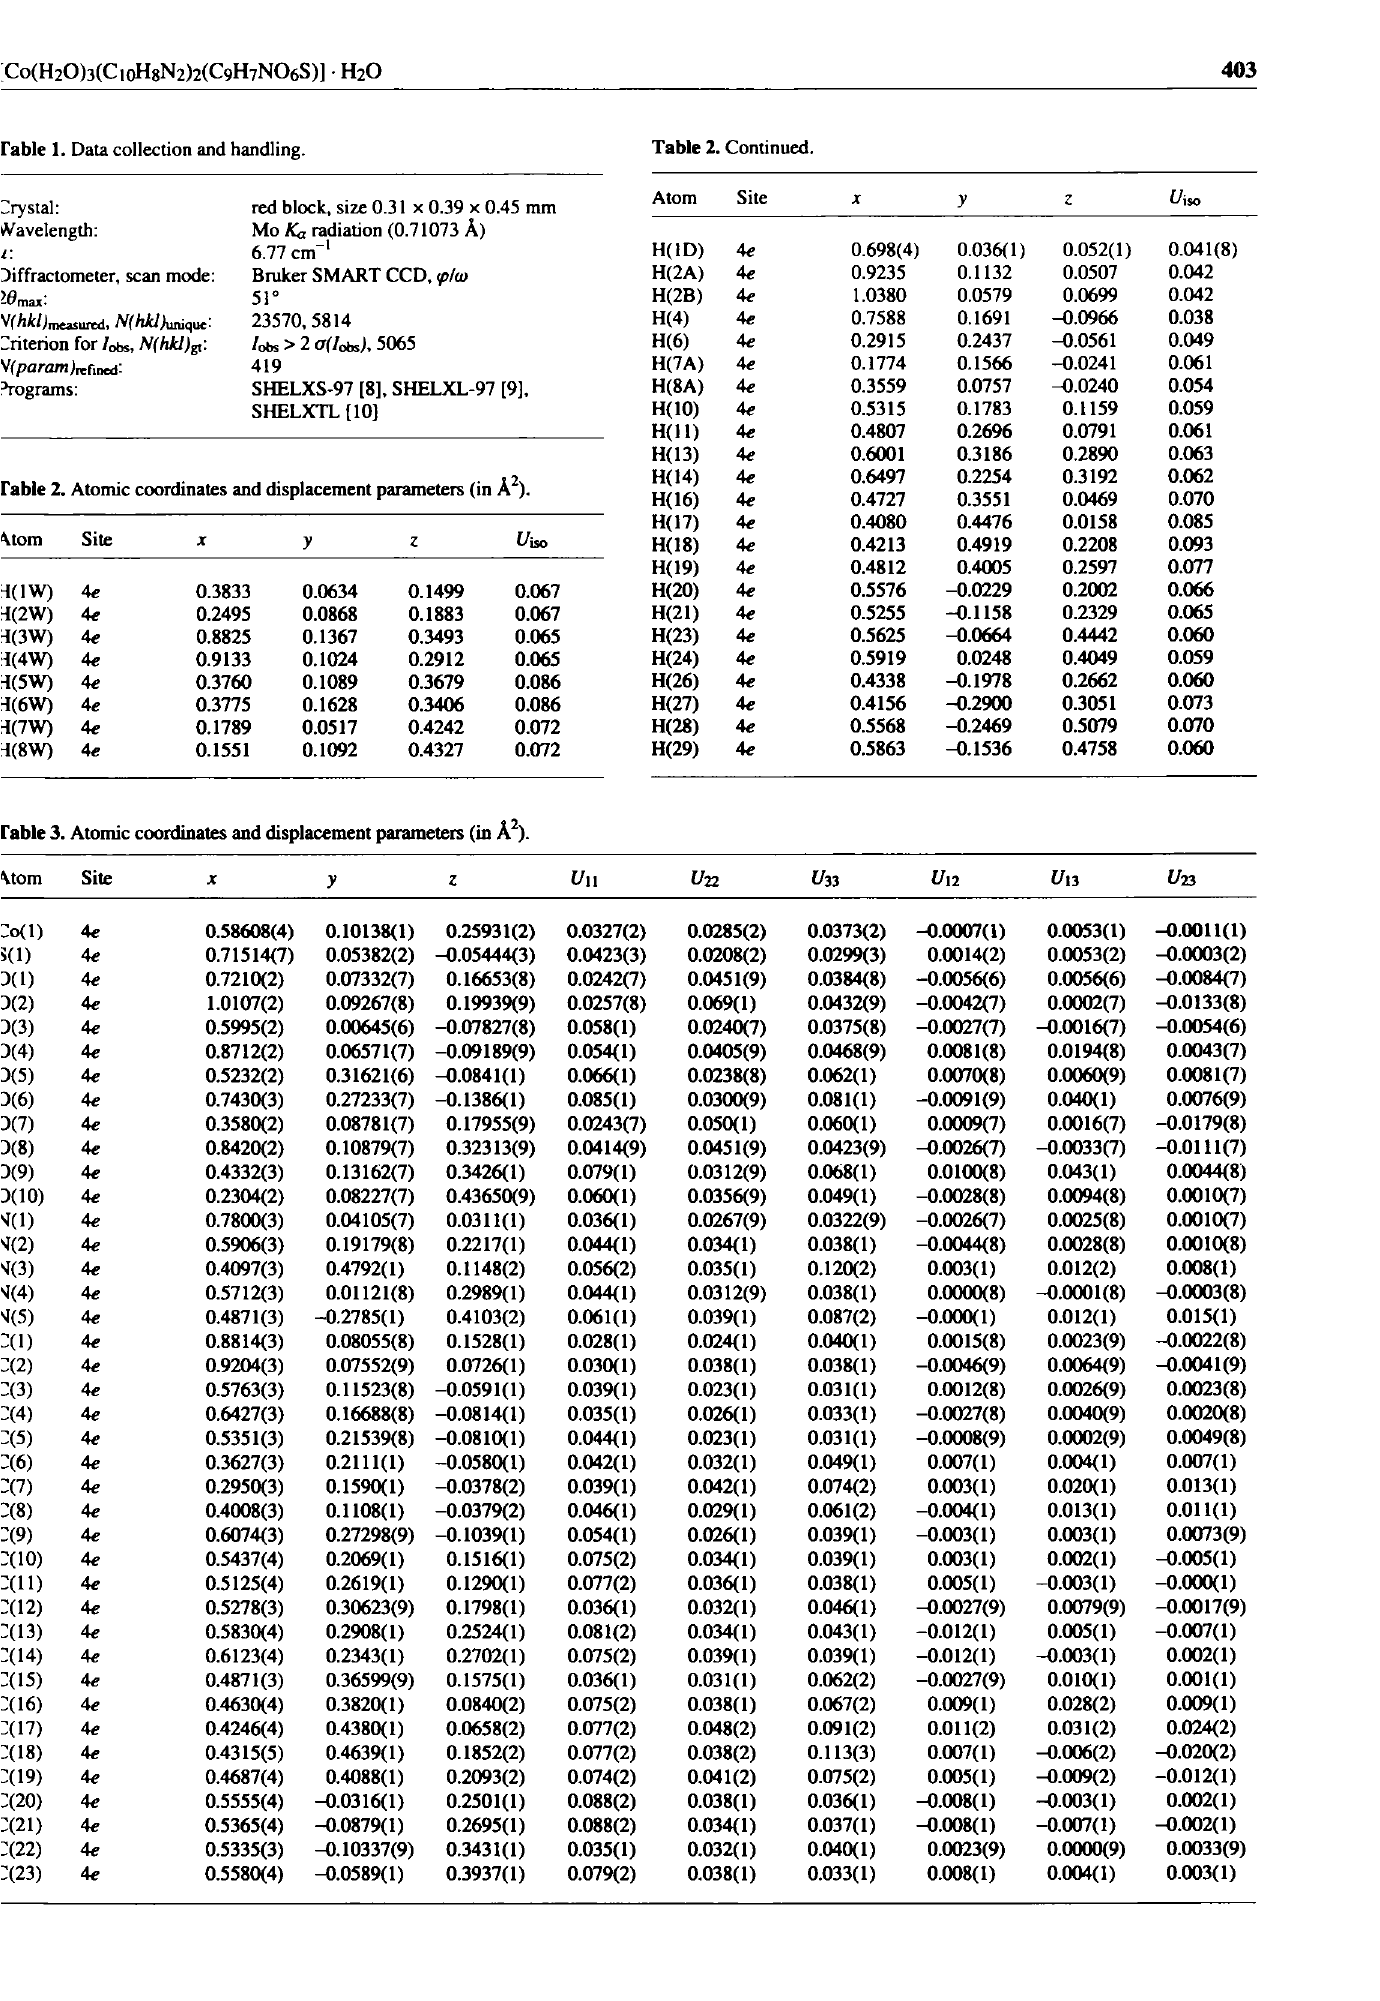
Table 2. Atomic coordinates and displacement parameters (in À 2 ).